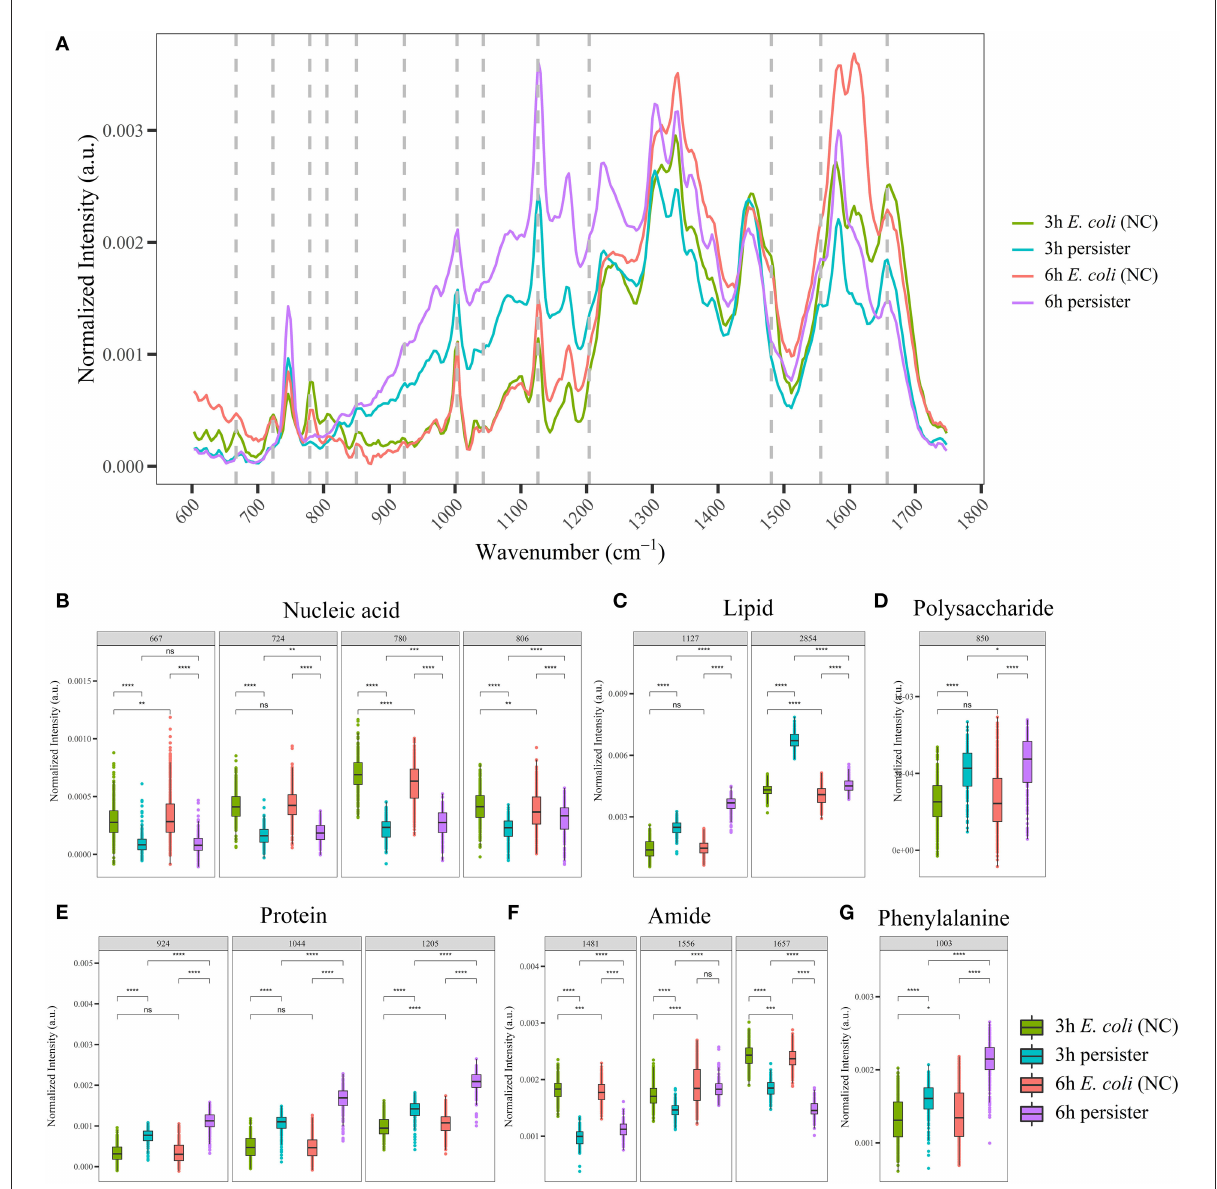
FIGURE1 Single-cell Raman spectra of E. coli persisters. Overnight planktonic-cultured E. coli (12h) was 1:100 diluted into fresh LB broth and further cultured for 3 and 6h, followed by ampicillin treatment (100 µ g/mL, 32 × MIC) for 4h. Single-cell Raman spectra were acquired afterward. (A) Mean spectra of E. coli and its persisters, normalized by the sum of fingerprint area from 600 to 1,750 cm − 1 . (B–G) Intensity of Raman bands for major cellular components: nucleic acid (B) , lipid (C) , polysaccharide (D) , proteins (E) , amide (F) , and phenylalanine (G) . ns, no significance; NC, E. coli cells without ampicillin treatment; * P < 0.05; ** P < 0.01; *** P < 0.001, **** P < 0.0001.